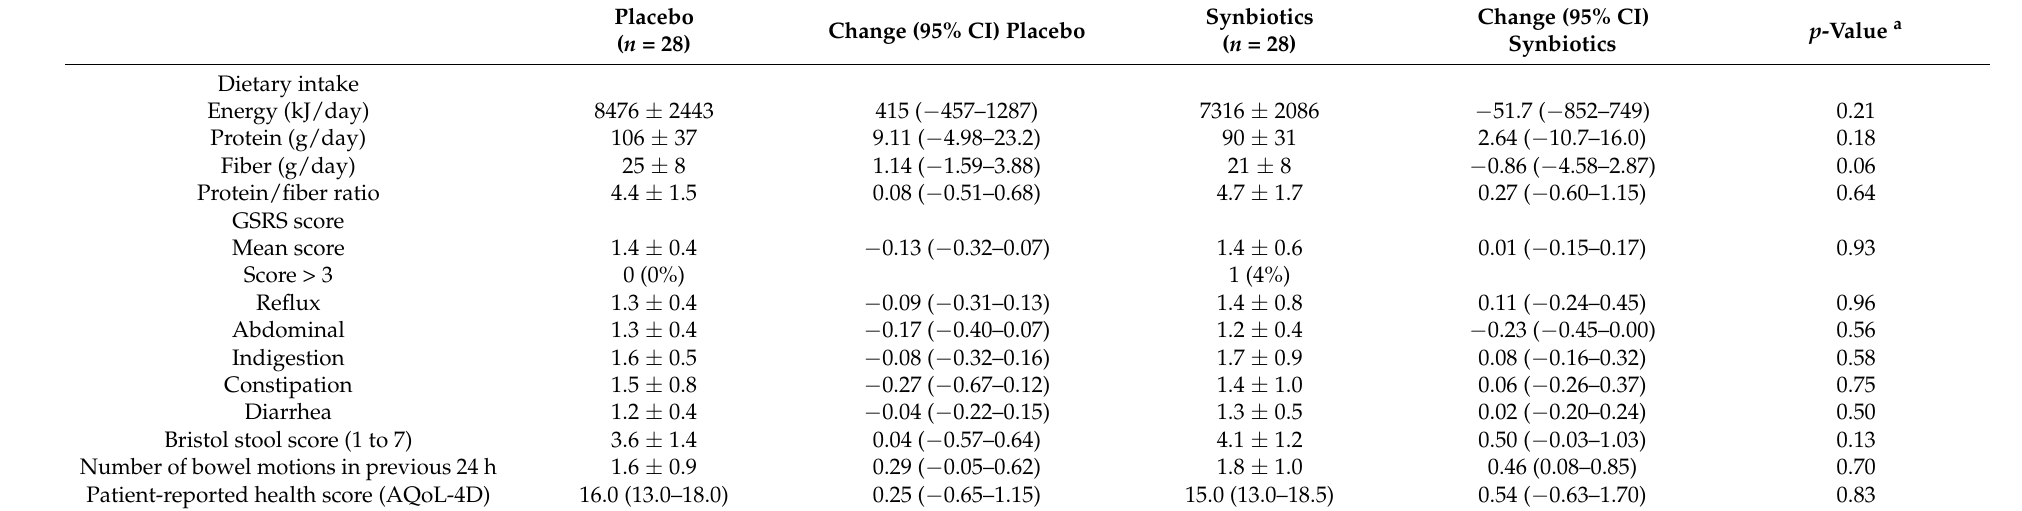
Table 2. Dietary intake and gastrointestinal symptoms at the end of intervention and changes from